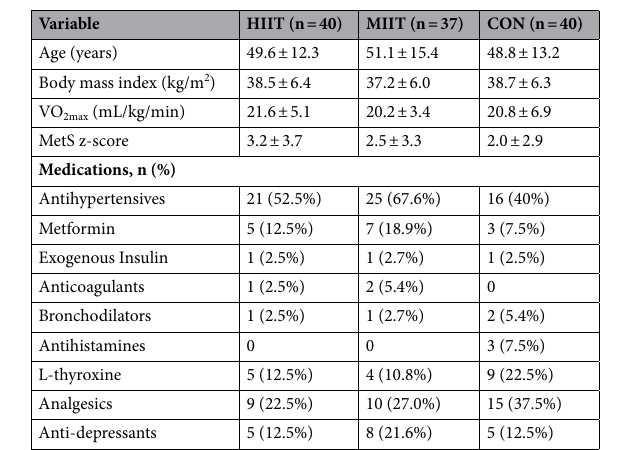
Table 1. Baseline characteristics of study participants and medications. HIIT high-intensity interval training group, MIIT moderate-intensity interval training group, CON control group, VO 2max maximal oxygen uptake, MetS z-score metabolic syndrome